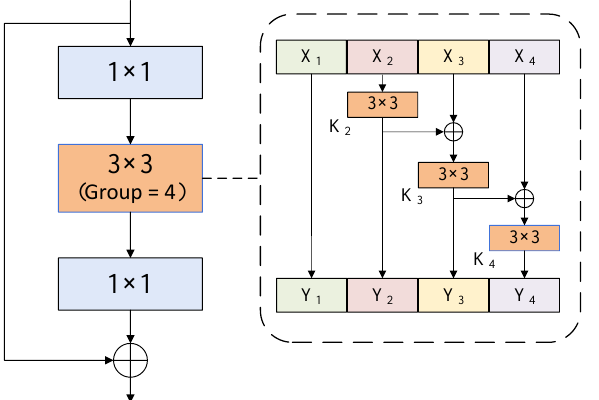
Figure 3. Hierarchical architecture of bottleneck blocks. On the left is the bottleneck block structure in the original residual network. In this paper, the intermediate convolution of the standard bottleneck structure is replaced by the multi-level convolution group on the right.